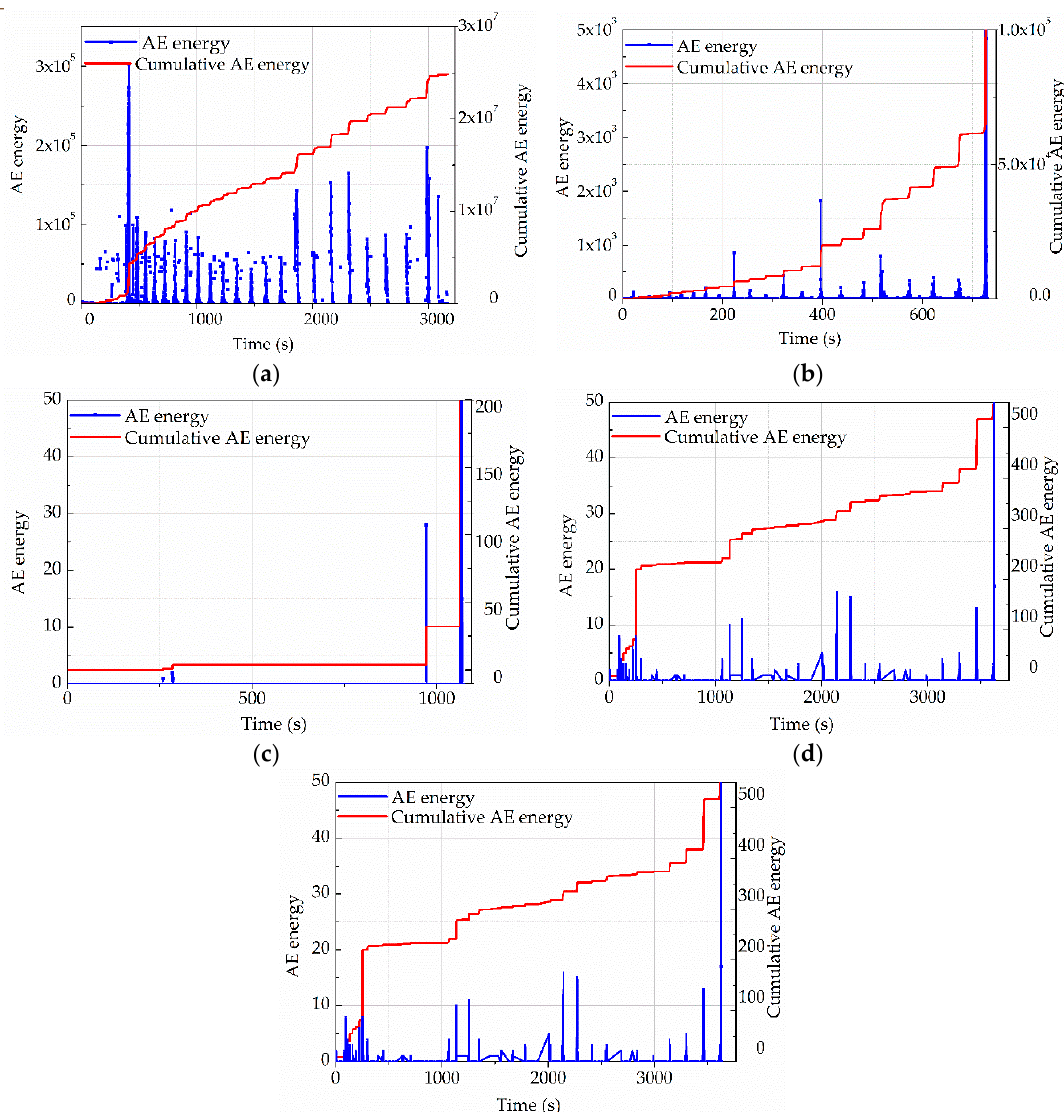
Figure 13. Cumulative acoustic emission (AE) energy and AE energy rate with respect to time. ( a ) Granite, ( b ) coal, ( c ) high-water material, ( d ) red sandstone, and ( e ) gypsum.